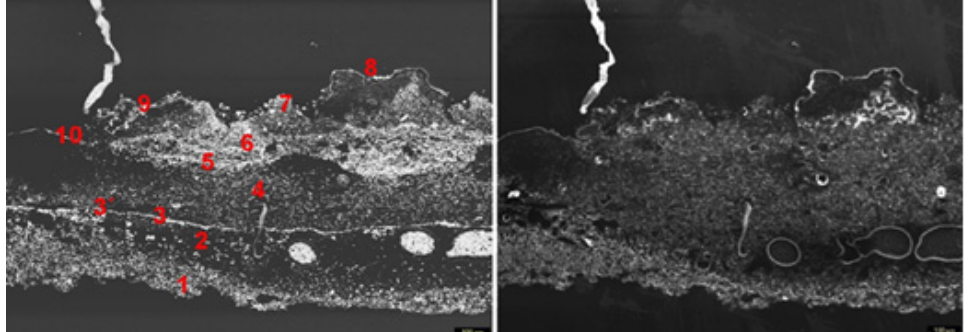
Figure 5. SEM images of PD-I taken in backscattered electron mode (BSE) (left) and secondary electron mode (SE). Numbers 1 to 10 correspond to points analysis whose results are in Table 2.